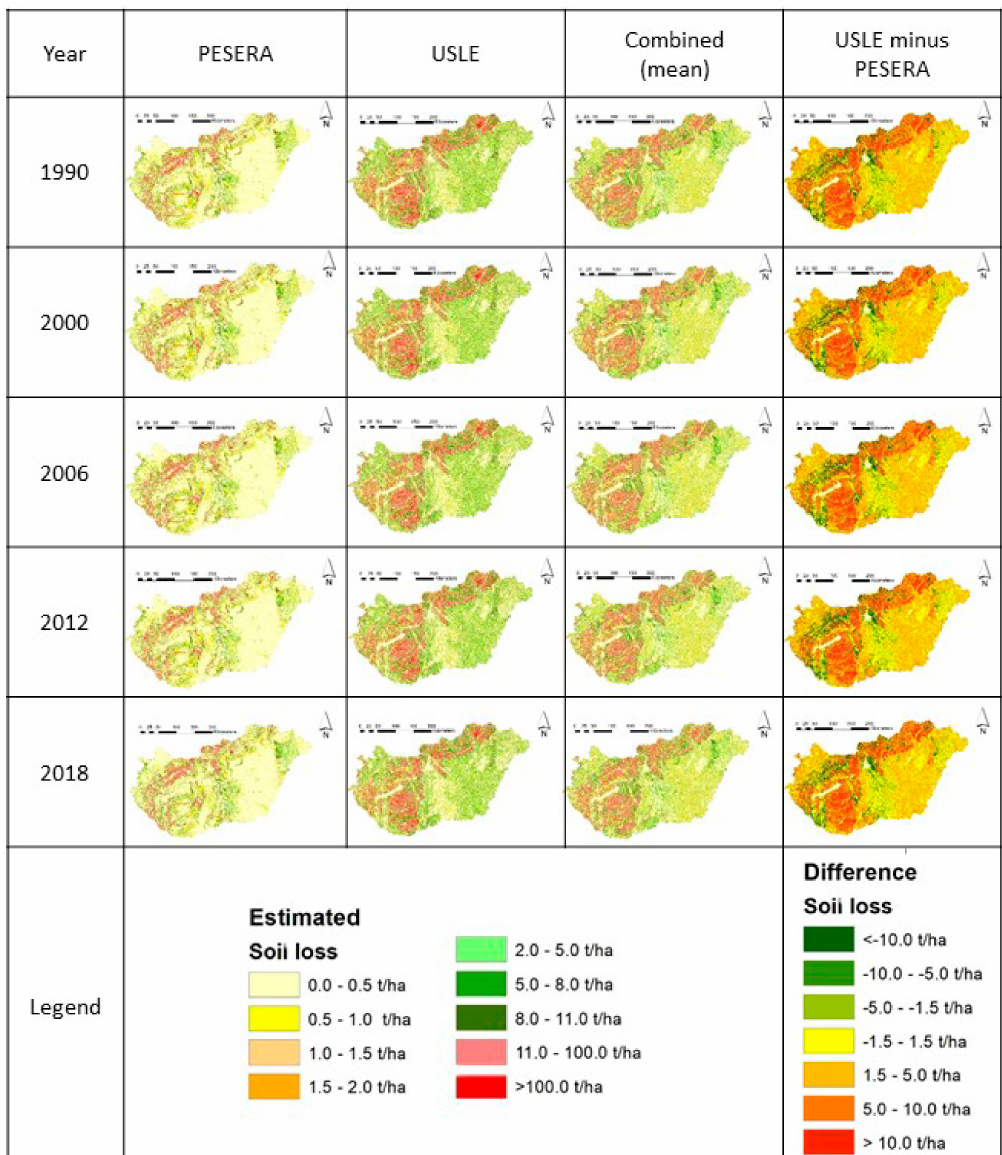
Figure A1. Erosion estimates for the observed years and applied